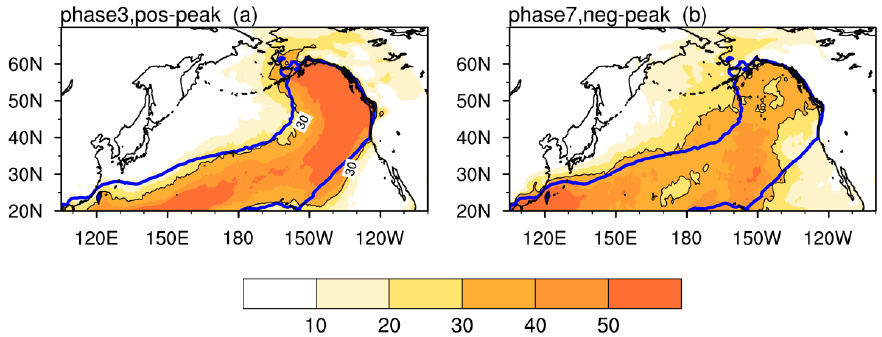
Figure 11. As in Figure 5c, 5g, but for the integrated water vapor (IWV) method.